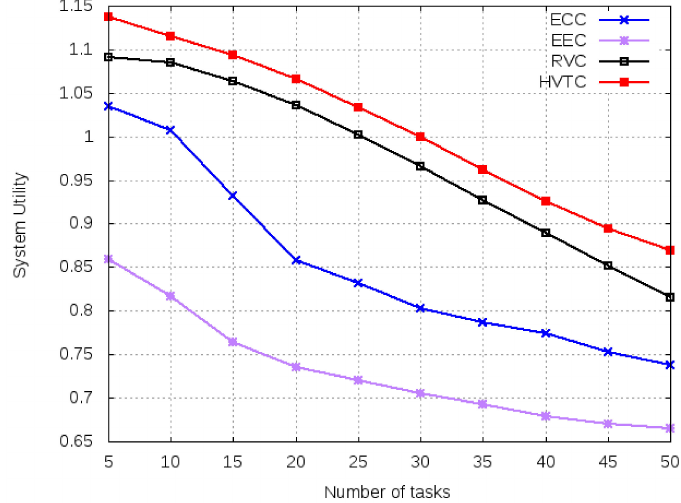
Figure 7. System utility for a varied number of tasks.